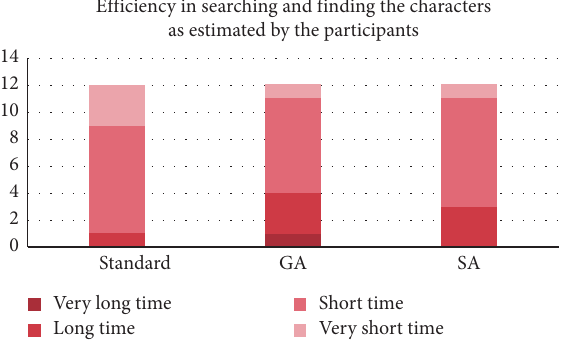
Figure 9: The efficiency as evaluated by the participants.